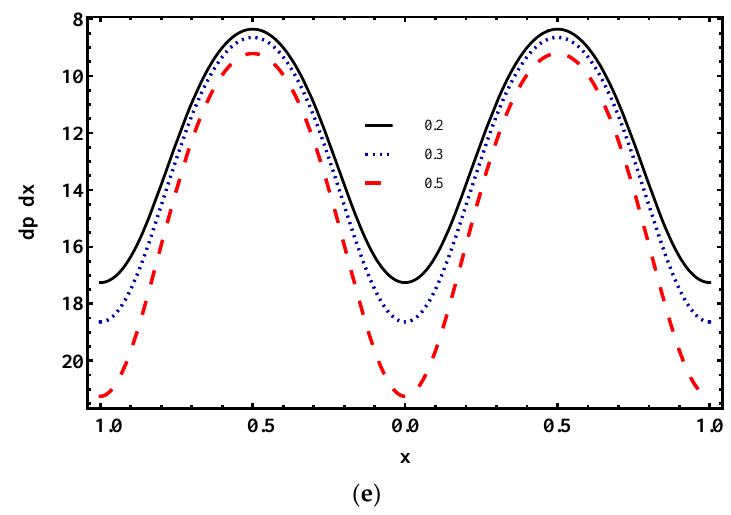
Figure 4. Pressure gradient profile for ( a ) W e ; ( b ) n i ; ( c ) m e ; ( d ) ; U HS ; ( e ) θ .